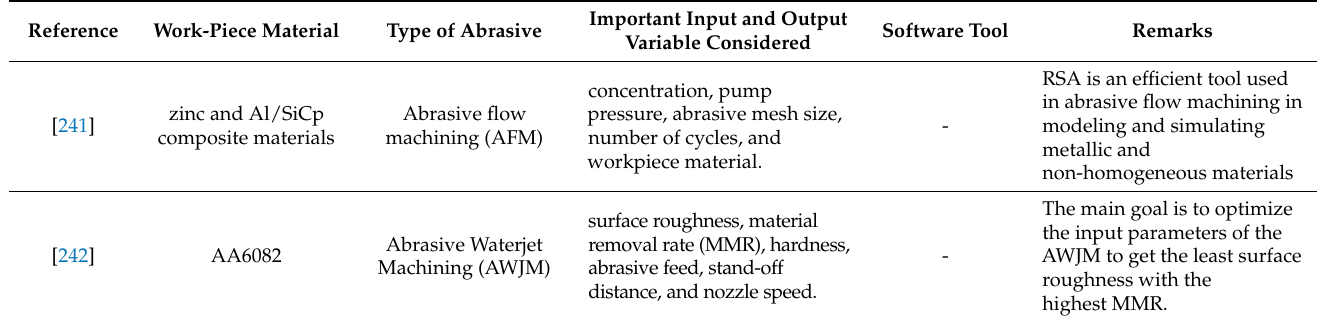
Table 12. Summary table of RSA-based modeling and simulation of the loose abrasive-based